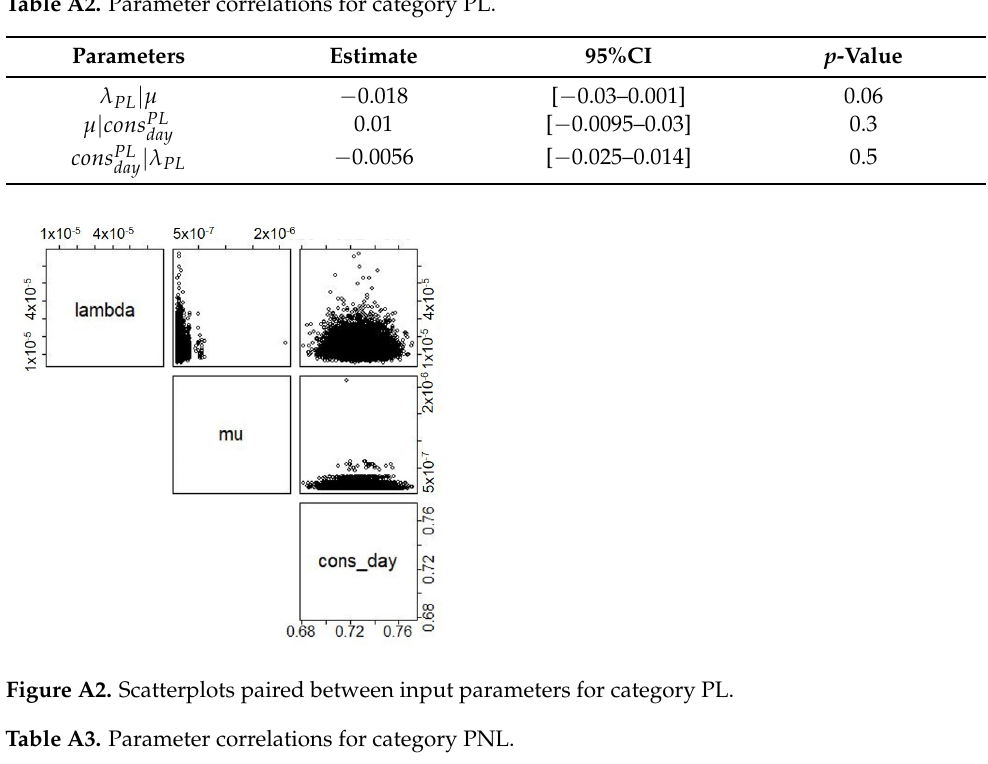
Table A2. Parameter correlations for category PL.